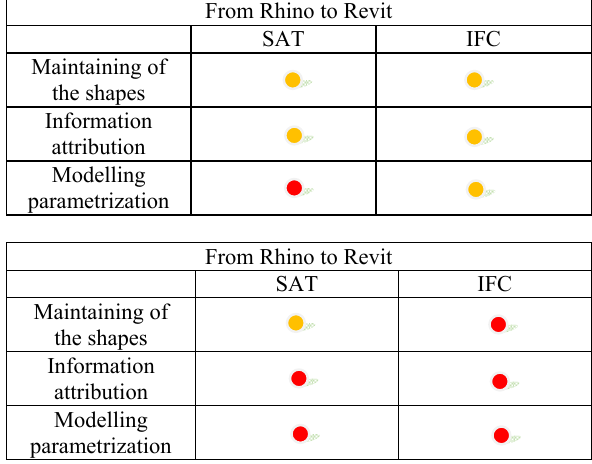
Table 5. The performances of the interoperability of the process from Rhino to Revit and vice versa.